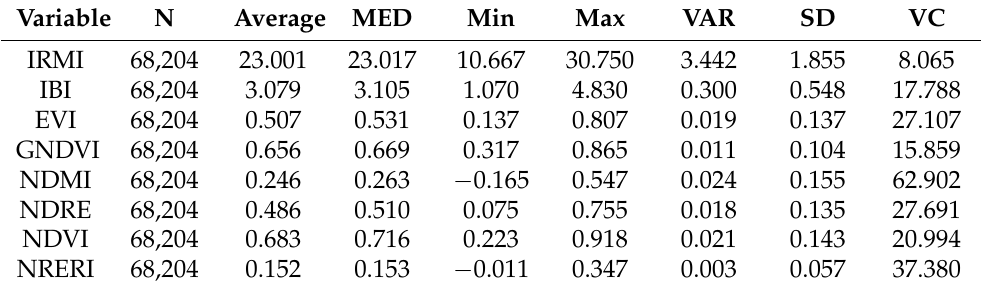
Table 3. Results of descriptive statistics—vegetation indices for the period 2017–2020.